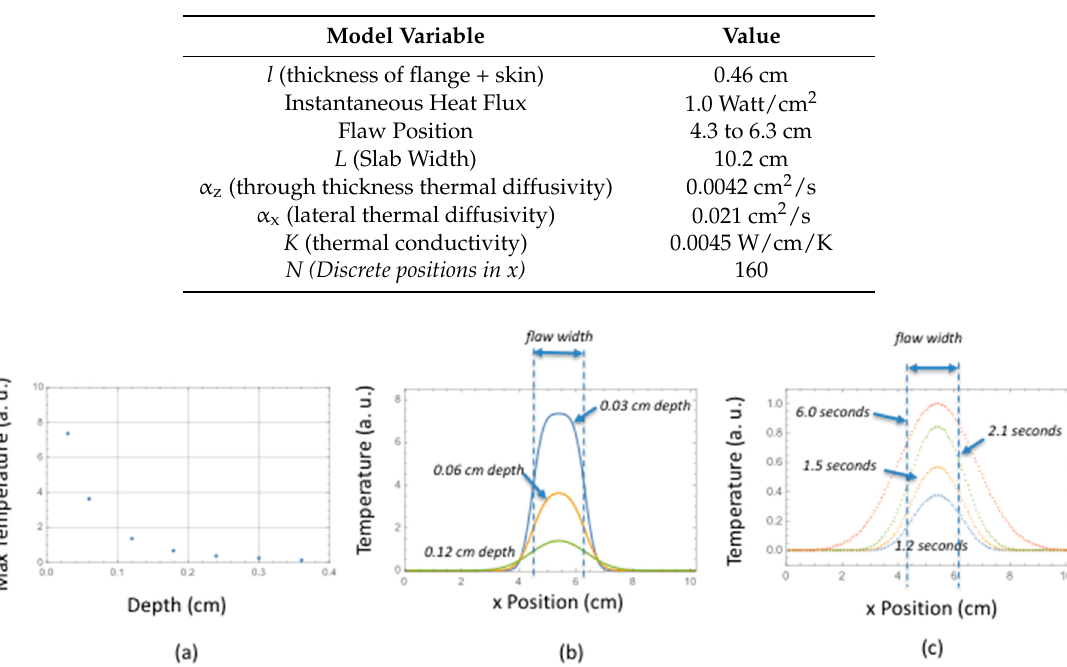
Table 3. Model values.